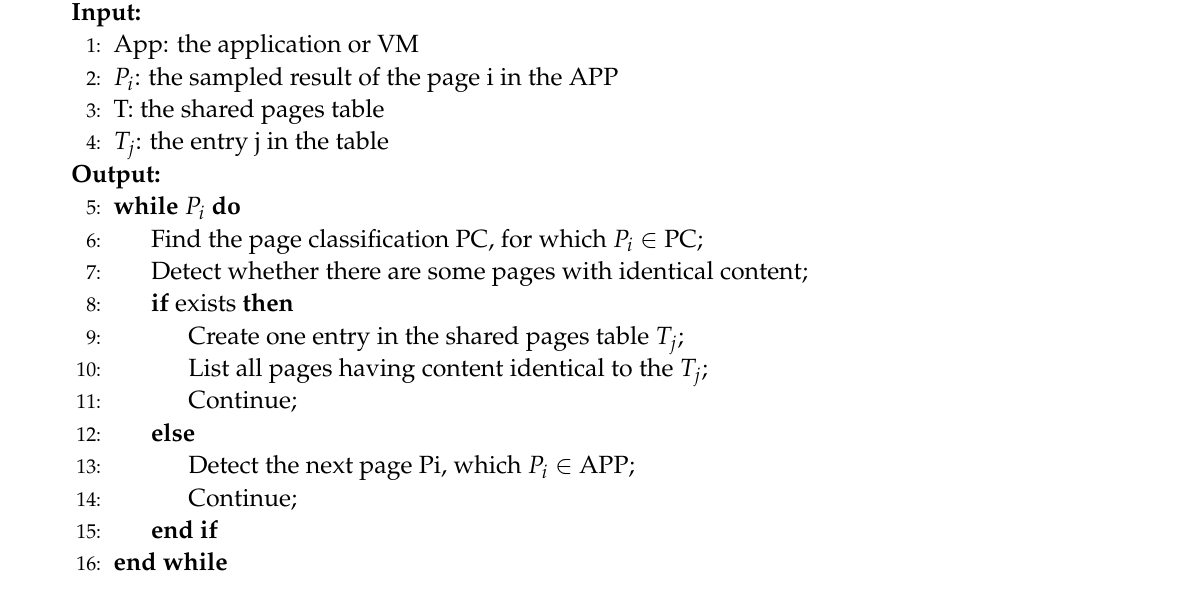
Algorithm 2 The shared pages table implementation algorithm (SPTIA)